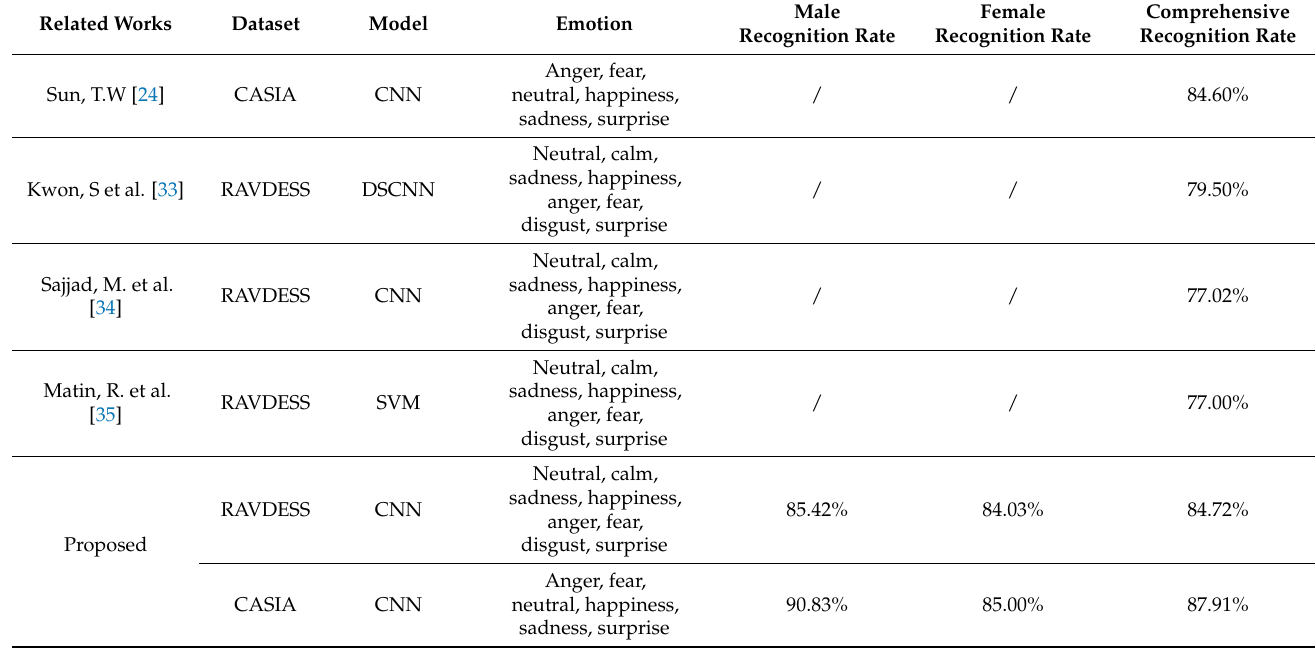
Table 4. Comparison of recognition results between previous works and proposed